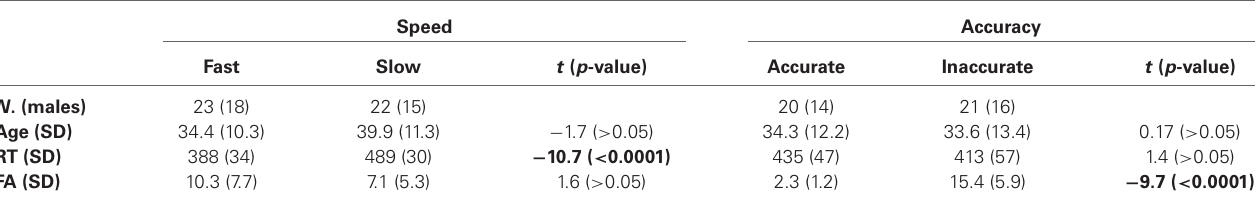
Table 1 | Comparison of demographic and behavioral data in the Speed- and Accuracy-groups